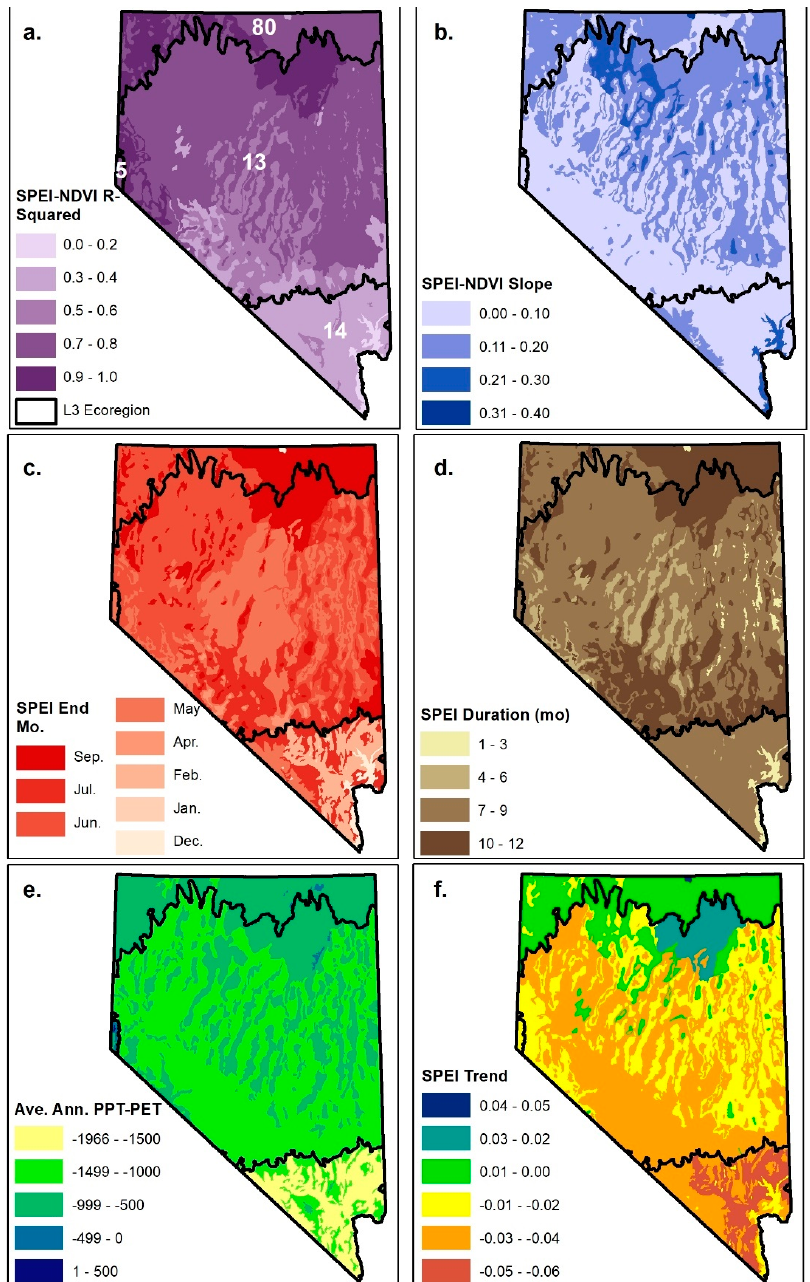
Figure 3. Relations between optimal Standardized Precipitation–Evapotranspiration Index (SPEI) timescale and annual median July–Sept NDVI (as percent difference from long-term mean) in riparian pixels (see Figure 1) by Level 4 ecoregion, including ( a ) R-squared and ( b ) regression slope coefficient of the optimal SPEI timescale and NDVI relationship, ( c ) end month, and ( d ) aggregation time scale of the optimal SPEI. Average annual water balance (PPT-PET) ( e ), which characterizes aridity (lower values = higher aridity), and the study period trend in optimal time scale SPEI ( f ; change in SPEI/year). Level 4 ecoregions are nested within Level 3 ecoregions (black lines) including the Northern (80), Central (13) and Mojave (14) Basin and Range, the Sierra Nevada (5), and the Arizona/New Mexico Plateau (22).